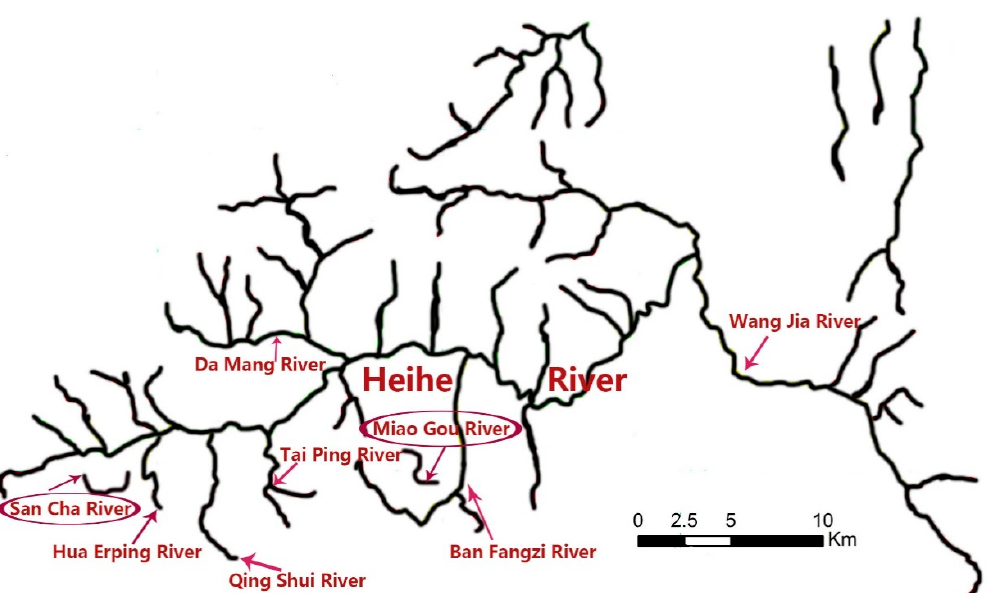
Figure 1. Geographic area of partial Heihe River (red circles represent locations where water samples were collected in our study). Table 1. The information on each site where we collected water for eDNA analysis (The site where the Batrachuperus species appeared when we collected water samples is shown with “+”, otherwise with “ − ”).